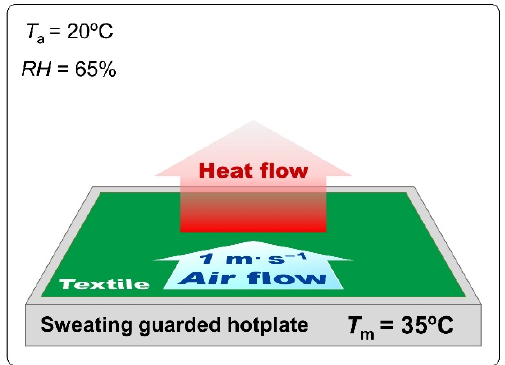
Figure 7. Conditions of textiles thermal resistance measurement.